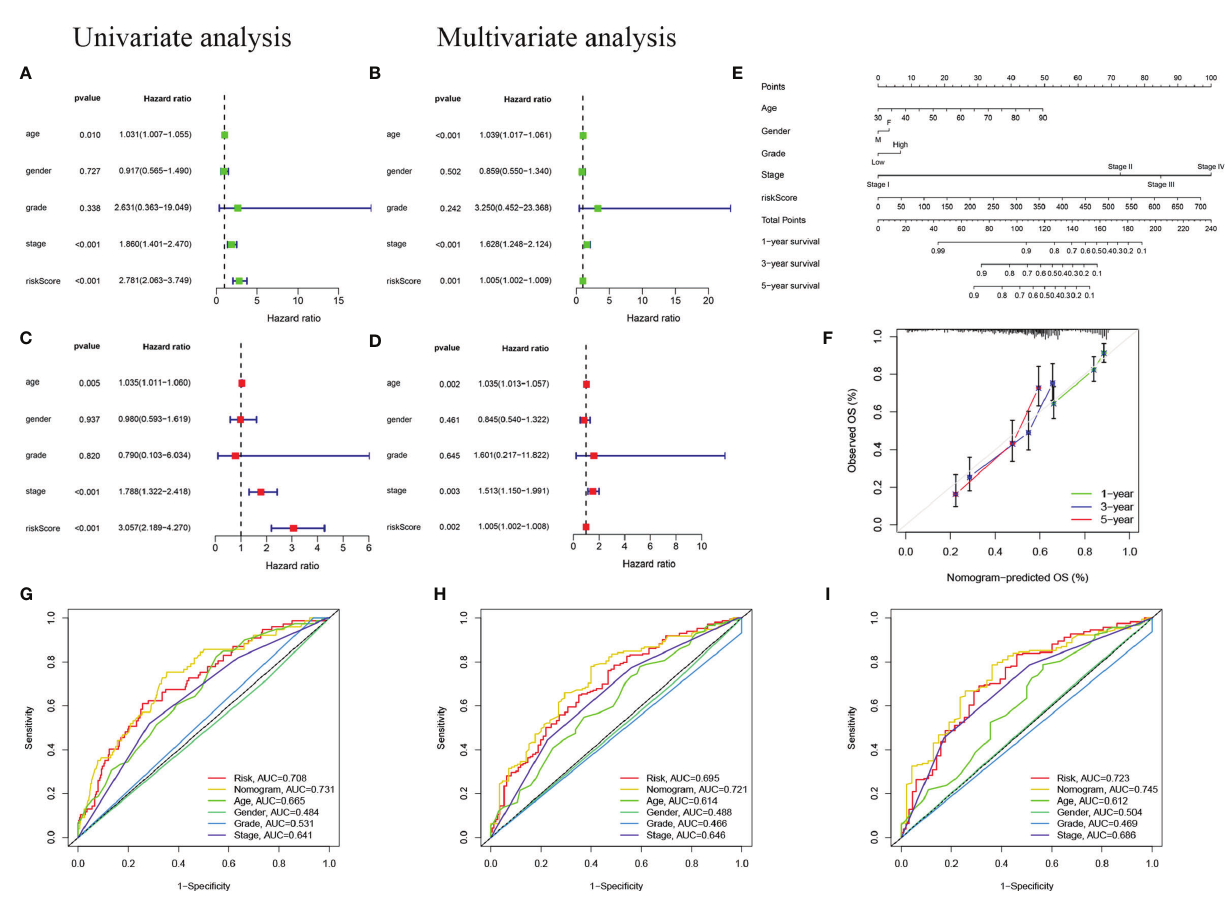
FIGURE 6 | Independent prognostic analysis. (A, B) Univariate (A) and multivariate (B) Cox regression analyses in the TCGA training cohort. (C, D) Univariate (C) and multivariate (D) Cox regression analyses in the TCGA validation cohort. (E) Nomogram based on age, gender, grade, stage, and risk score. (F) Calibration plot of a nomogram to predict 1-,3- and 5-year OS in the TCGA cohort. The x-axis represents the nomogram-estimated probabilities and the y-axis represents the observed probabilities. (G – I) Discriminatory accuracy for predicting OS assessed by receiver operator characteristics (ROC) analysis calculating the time-independent area under the curves (AUCs).1- (G) , 3- (H) , and 5-year (I) in the TCGA